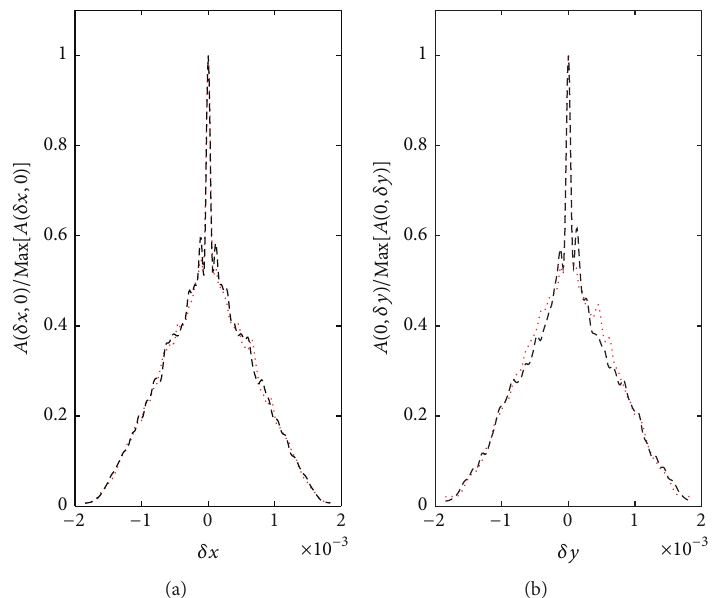
Figure 8: 𝑥 -cut (a) and 𝑦 -cut (b) of the central peak of the 2D-autocorrelation of the simulated speckle-like interferometric out-of-focus patterns for a random location of the emitters (black dashed lines) or a regular location of the emitters (red dotted lines). The 𝑥 -axes are expressed in meters, while the 𝑦 -axes represent normalized amplitudes (no